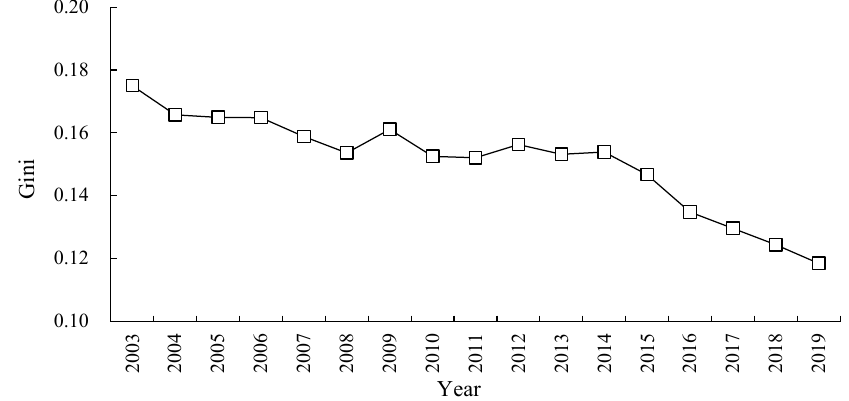
Figure 4. Overall difference and evolution trend of ECP in the YRB.